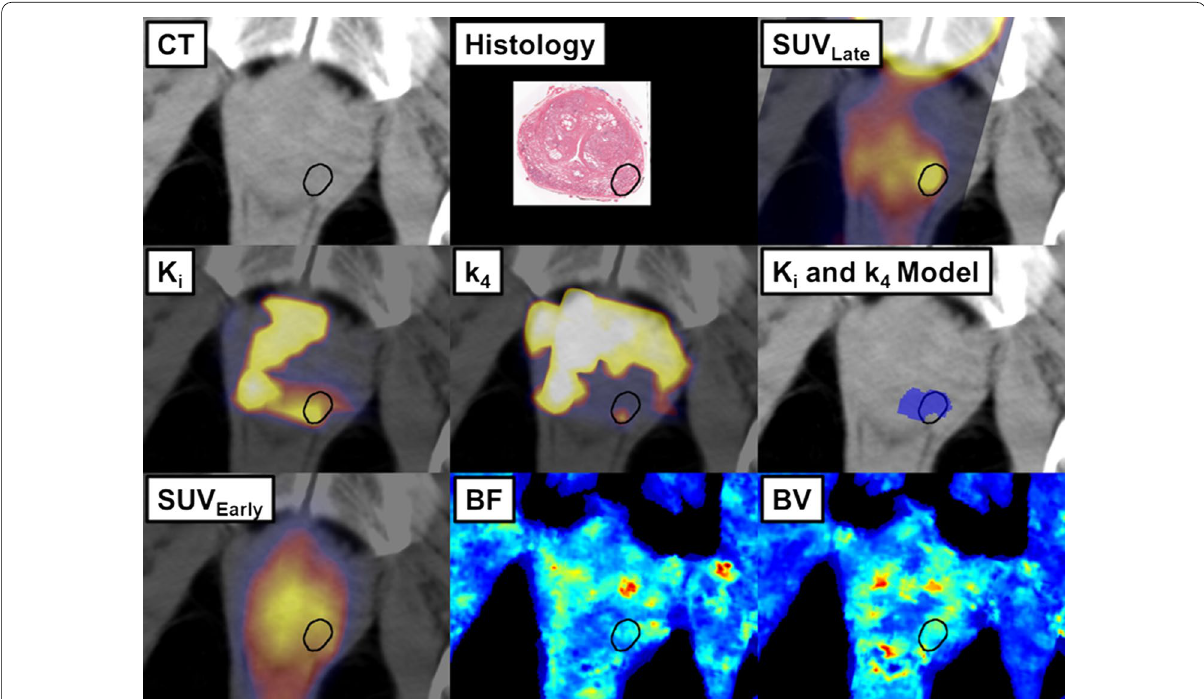
Fig. 4 Example of the co‑registered in vivo images and parametric maps. The location of DIL is outlined in black. CT Computed tomography, PET positron emission tomography, SUV Late 2‑h post‑injection standardized uptake value, K i net uptake rate constant, k 4 dissociation rate constant, SUV Early 10‑min post‑injection standardized uptake value, BF blood flow, BV blood volume, DIL dominant intraprostatic